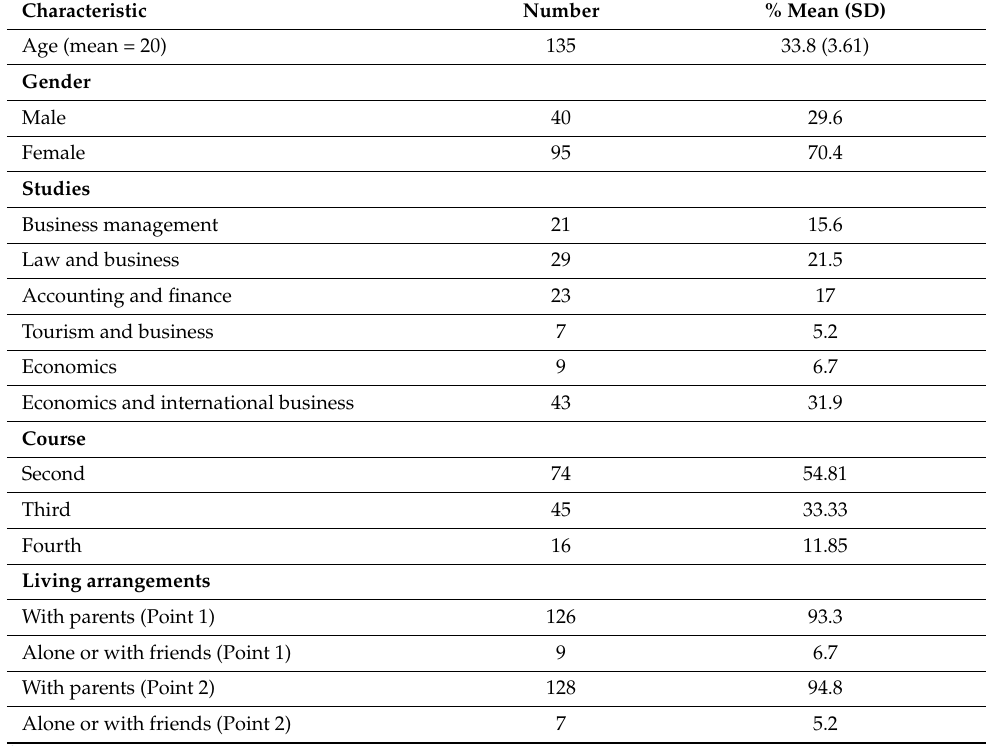
Table 1. Demographic and living